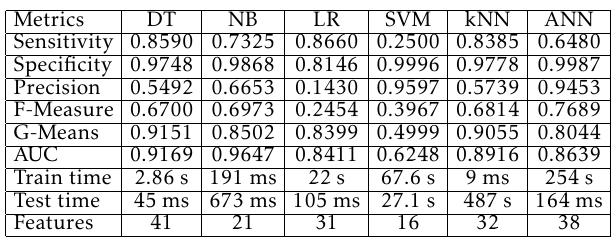
Table 17. Results of using CA-BFE algorithm on ANALYSIS.